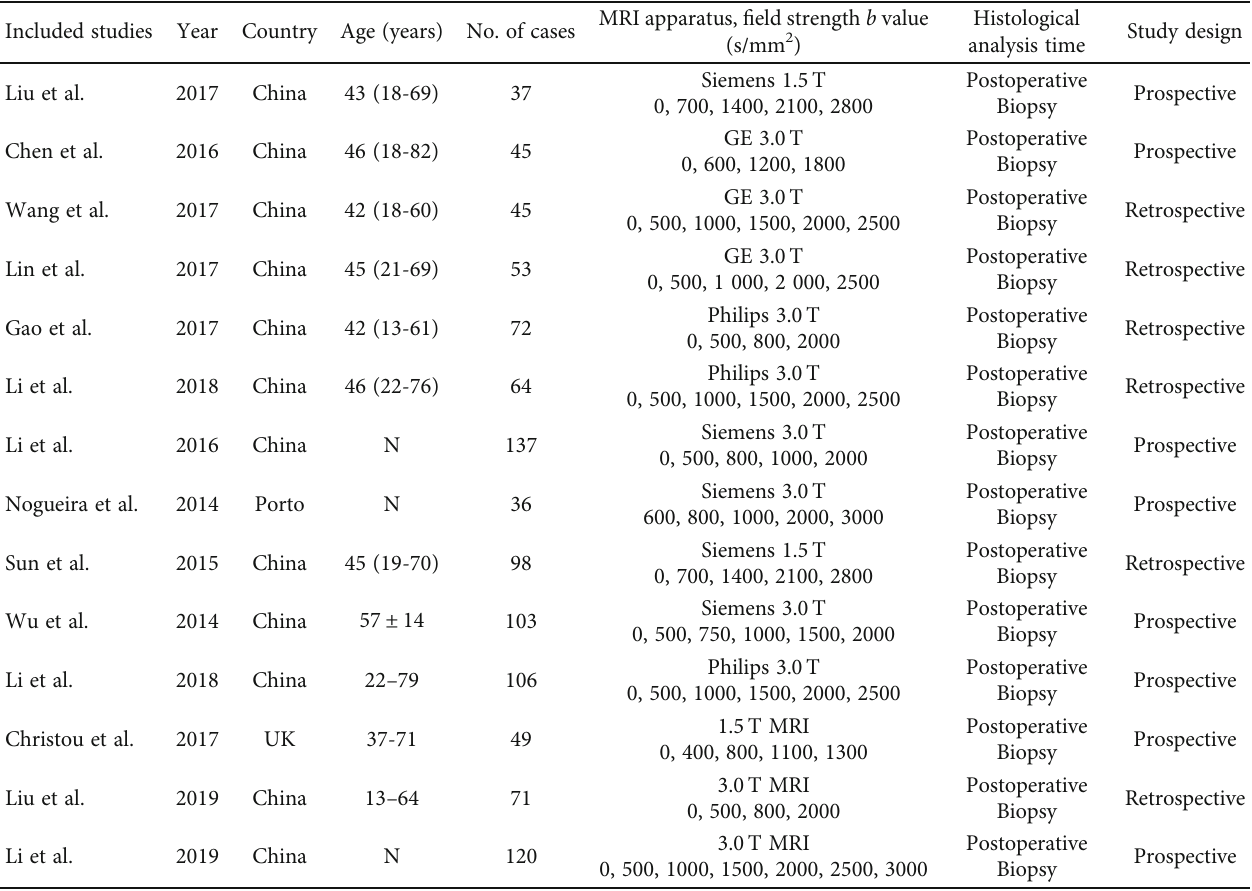
Figure 1: Flow diagram of study selection for meta-analysis. Table 1: Characteristics of the included studies in this